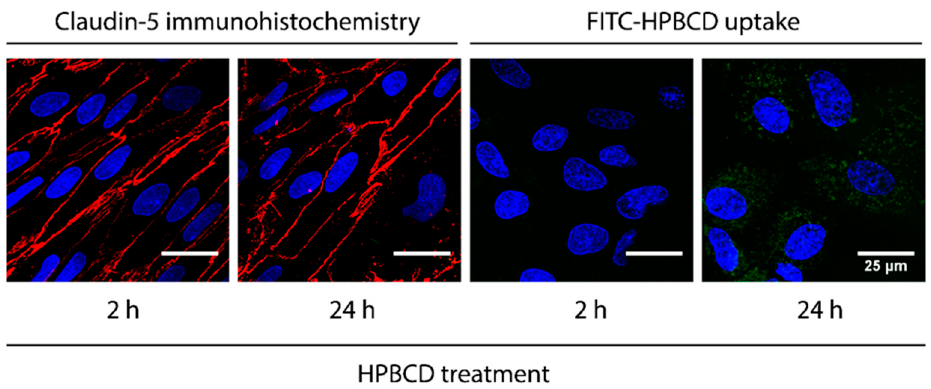
Figure 5. Visualization of the claudin-5 immunostaining (red) on fixed brain endothelial cells after HPBCD treatment (50 µM, 2 and 24 h) and the uptake of HPBCD (green) in living brain endothelial cells. Blue: cell nuclei. Bar: 25 µm.